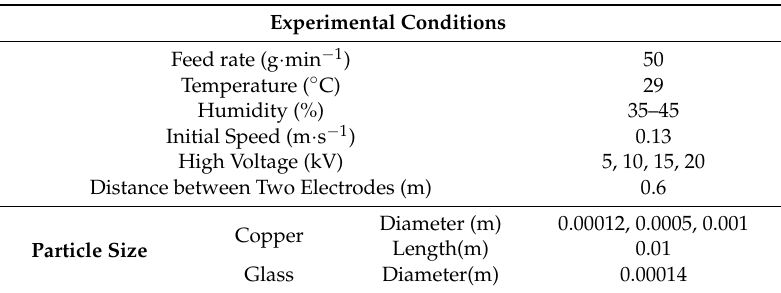
Figure 4. Schematic of a lab-scale induction electrostatic separator set. Table 2. Conditions of experiment and simulation variables in particle trajectory.